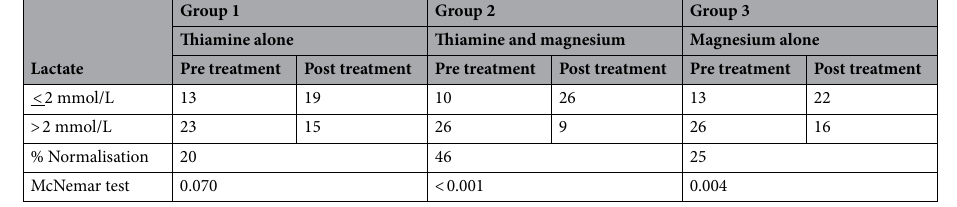
Table 4. Pre- and post-treatment plasma lactate (all